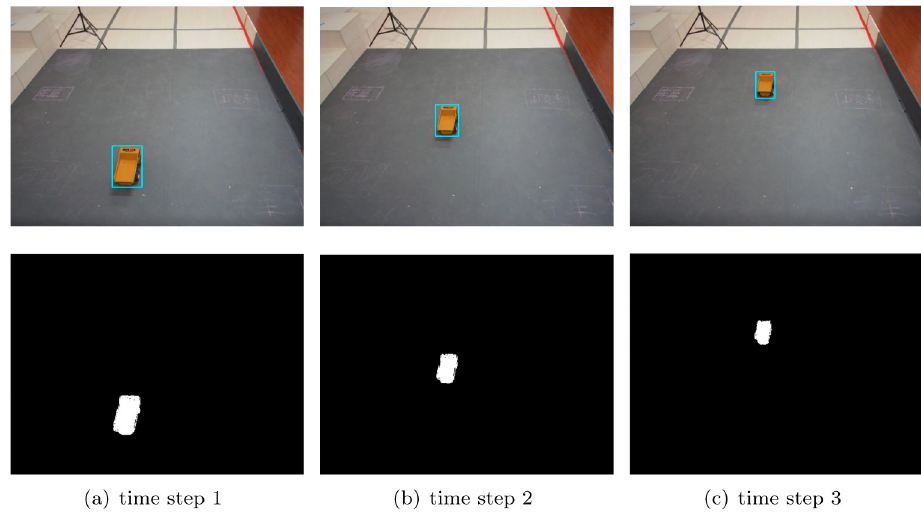
Fig 6. Shadow removal results at different time steps with our DC-SR method under real-time monitoring, when object moves in a straight line. (a) time step 1. (b) time step 2. (c) time step 3.